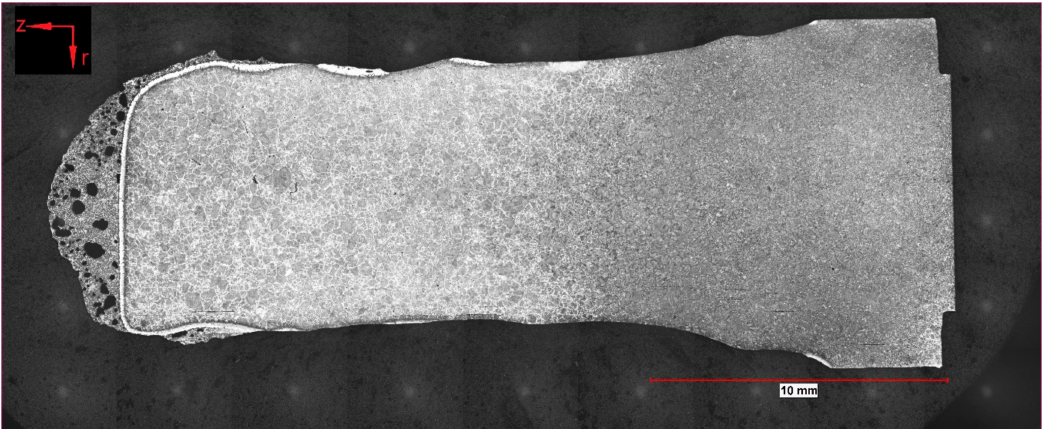
Figure 6. Nital-etched longitudinal area of rotating sample number 59, submerged for 60 s into hot metal with an equilibrium temperature between scrap core and hot metal of 1385 ◦